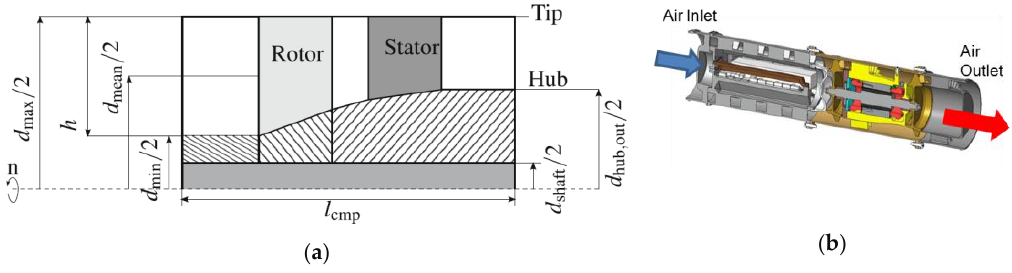
Figure 11. Axial compressor: ( a ) Schematic (image courtesy of [18]); ( b ) cutaway diagram (image courtesy of SAFRAN Ventilation Systems).